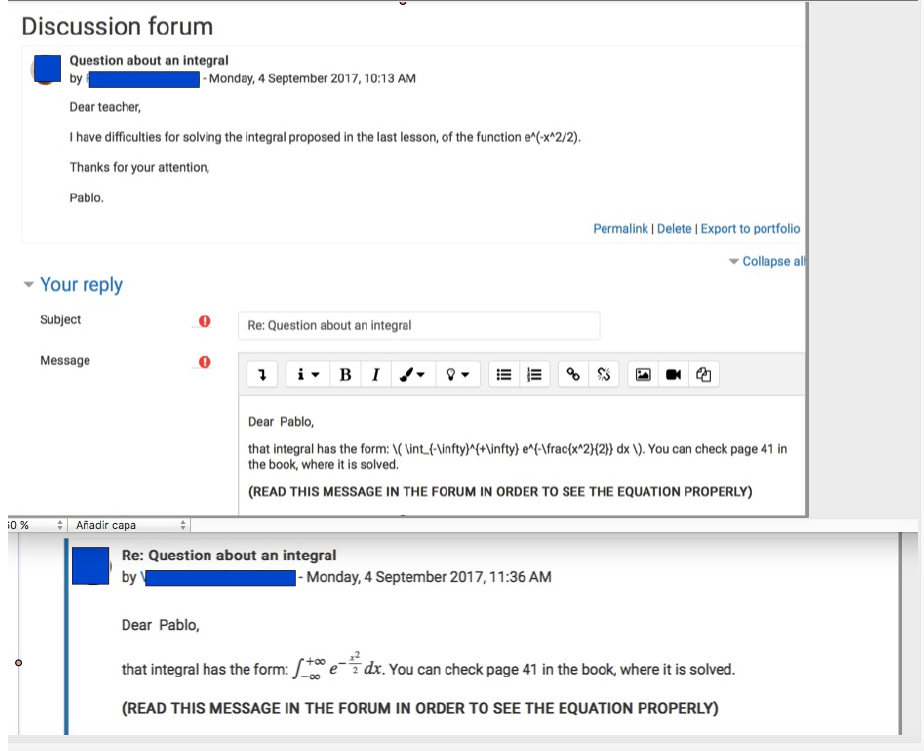
Figure 1. Communication through a Virtual Learning Environment (VLE) forum by using L A TEX com- mands. In the upper part the editing part is shown, while in the lower part the effect that the L A TEX com- piler produces on the written code